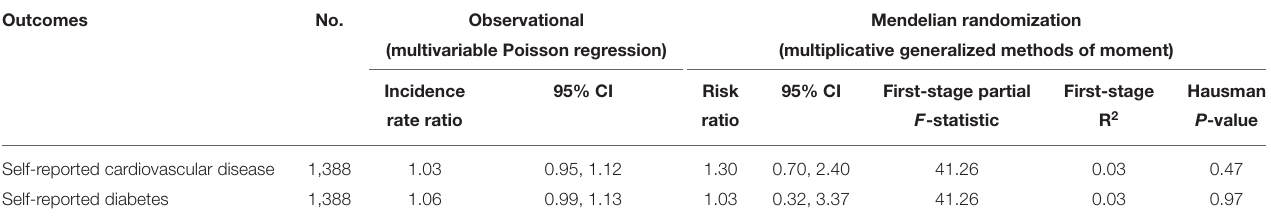
TABLE 5 | Adjusted † association of cortisol with self-reported CVD and diabetes based on Mendelian randomization using genetically predicted log-transformed cortisol from internally weighted polygenic score and observational multivariable Poisson regression for 1,562 Hong Kong Chinese adults from Hong Kong’s FAMILY Cohort.